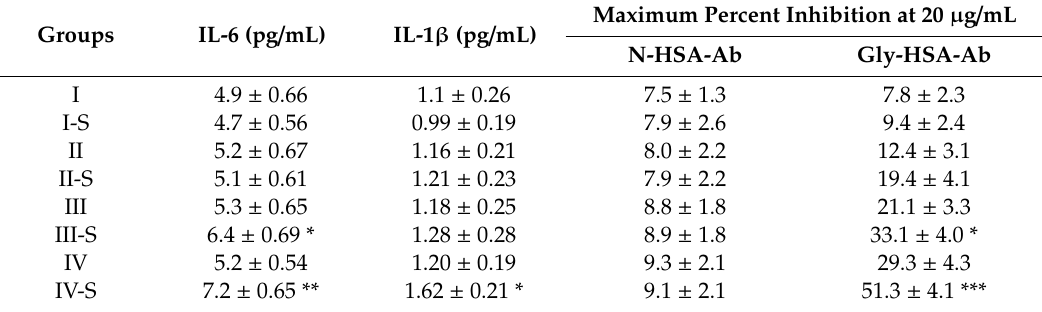
Table 3. Immunological characteristics of di ff erent individuals based on di ff erent age groups with or without smoking